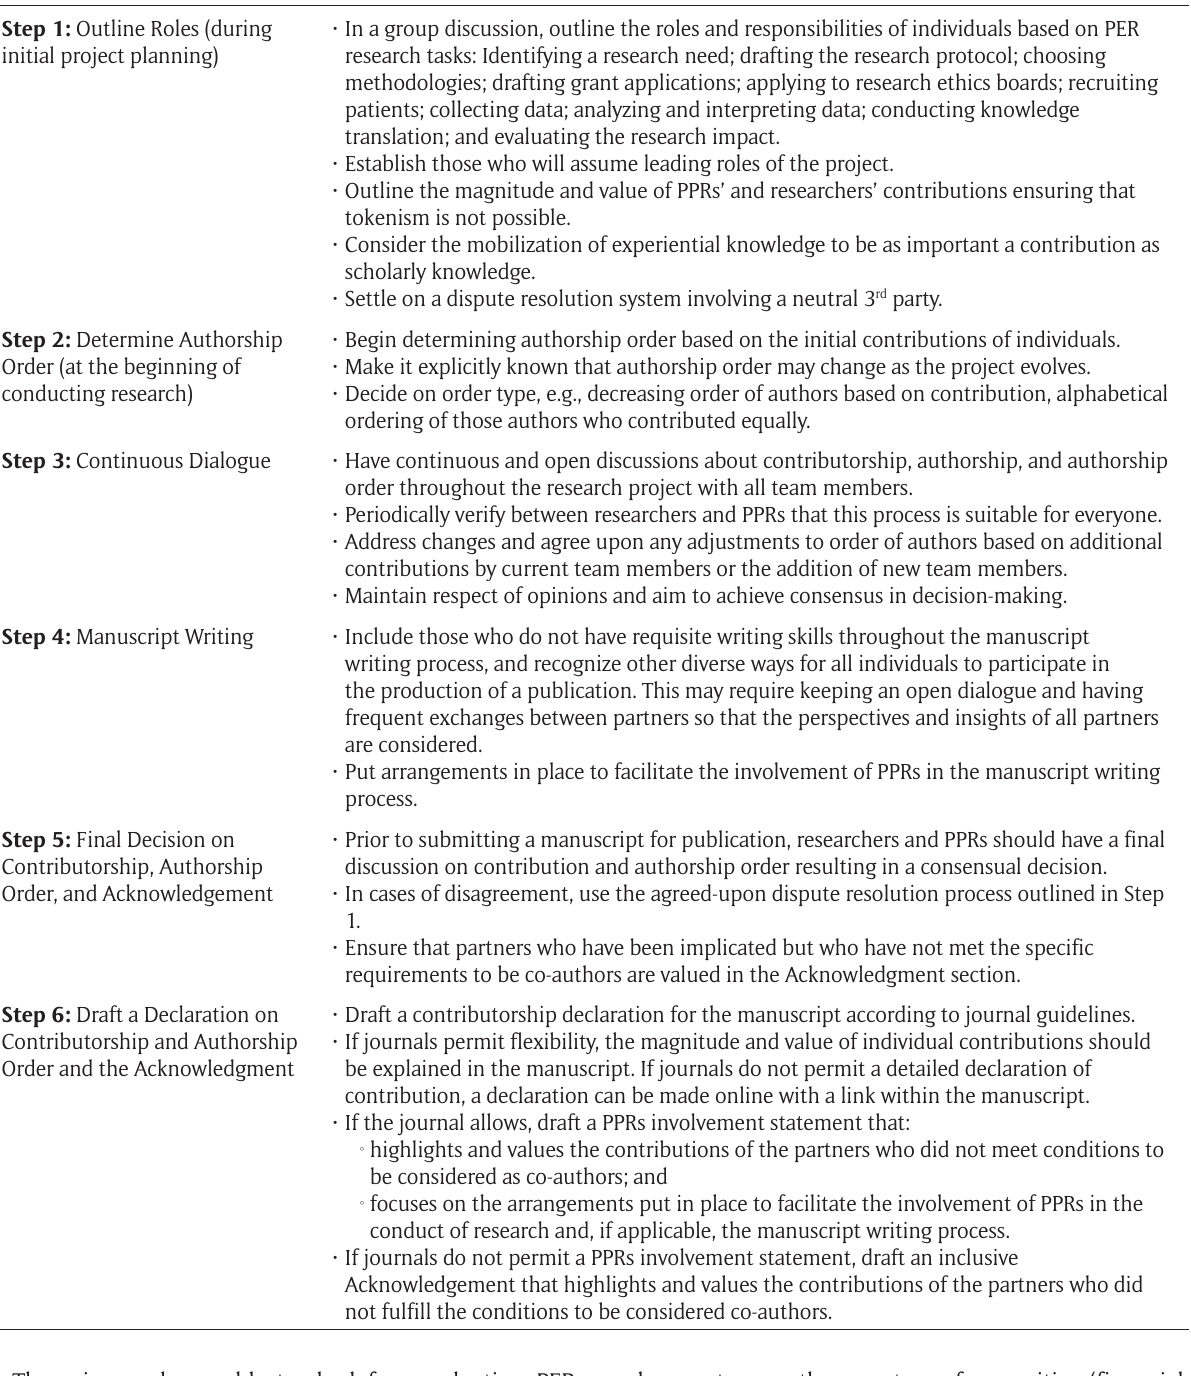
Table 3: Best Practices to Determine Contributorship and Authorship Order in Patient Engagement Research (Adapted from Smith and Master 2017). initial project